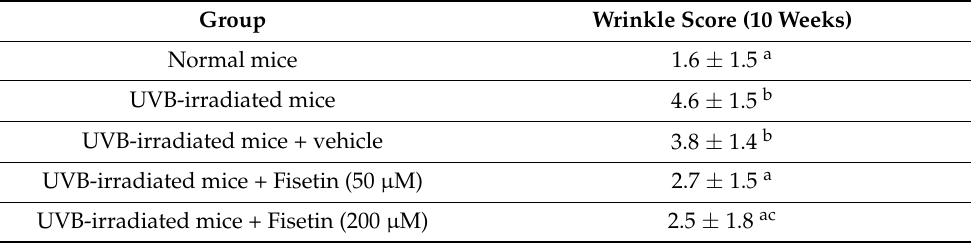
Figure 3. Images of UVB-induced skin wrinkles and the effects of topically applied fisetin. Table 1. Effects of fisetin on UVB-induced skin wrinkles in the hairless mice.